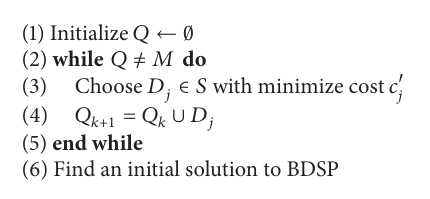
Algorithm 2: Greedy constructive